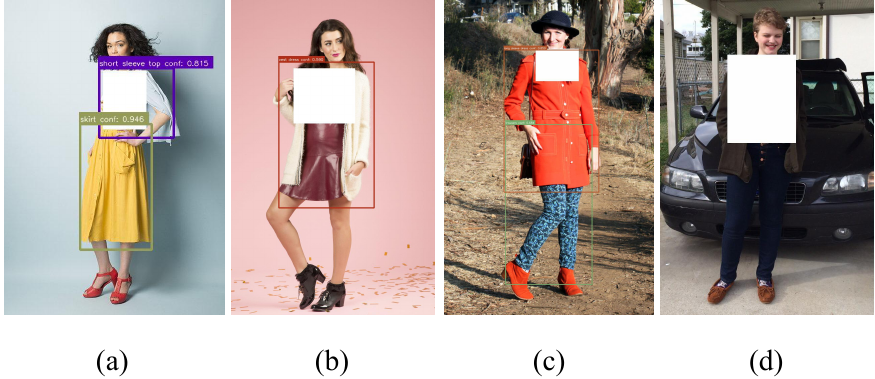
Figure 4. Some results from YOLOv3 (pre-trained on DeepFashion2) on Street2Shop dataset. Example ( a , b ) have a single-color background while ( c , d ) have a complex background. The detection results in ( a – d ) are not